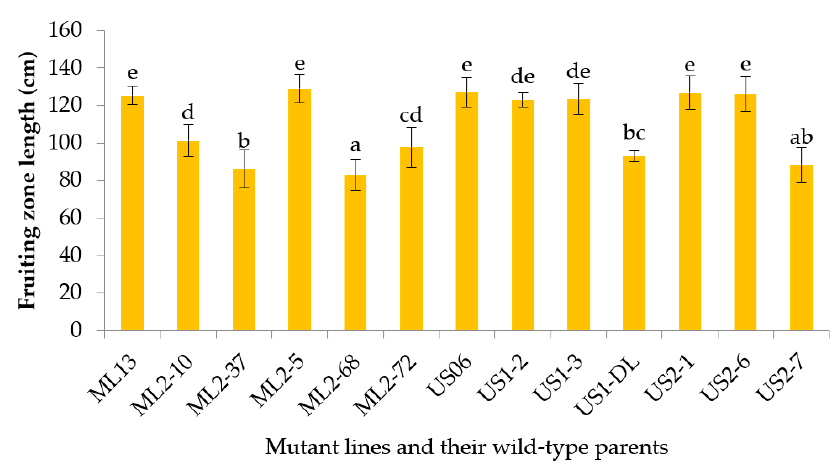
Figure 5. Fruiting zone length (FZL) in 11 sesame mutant lines and their two wildtypes (US06 and ML13). The superscript letters represent the groups according to Duncan’s test.